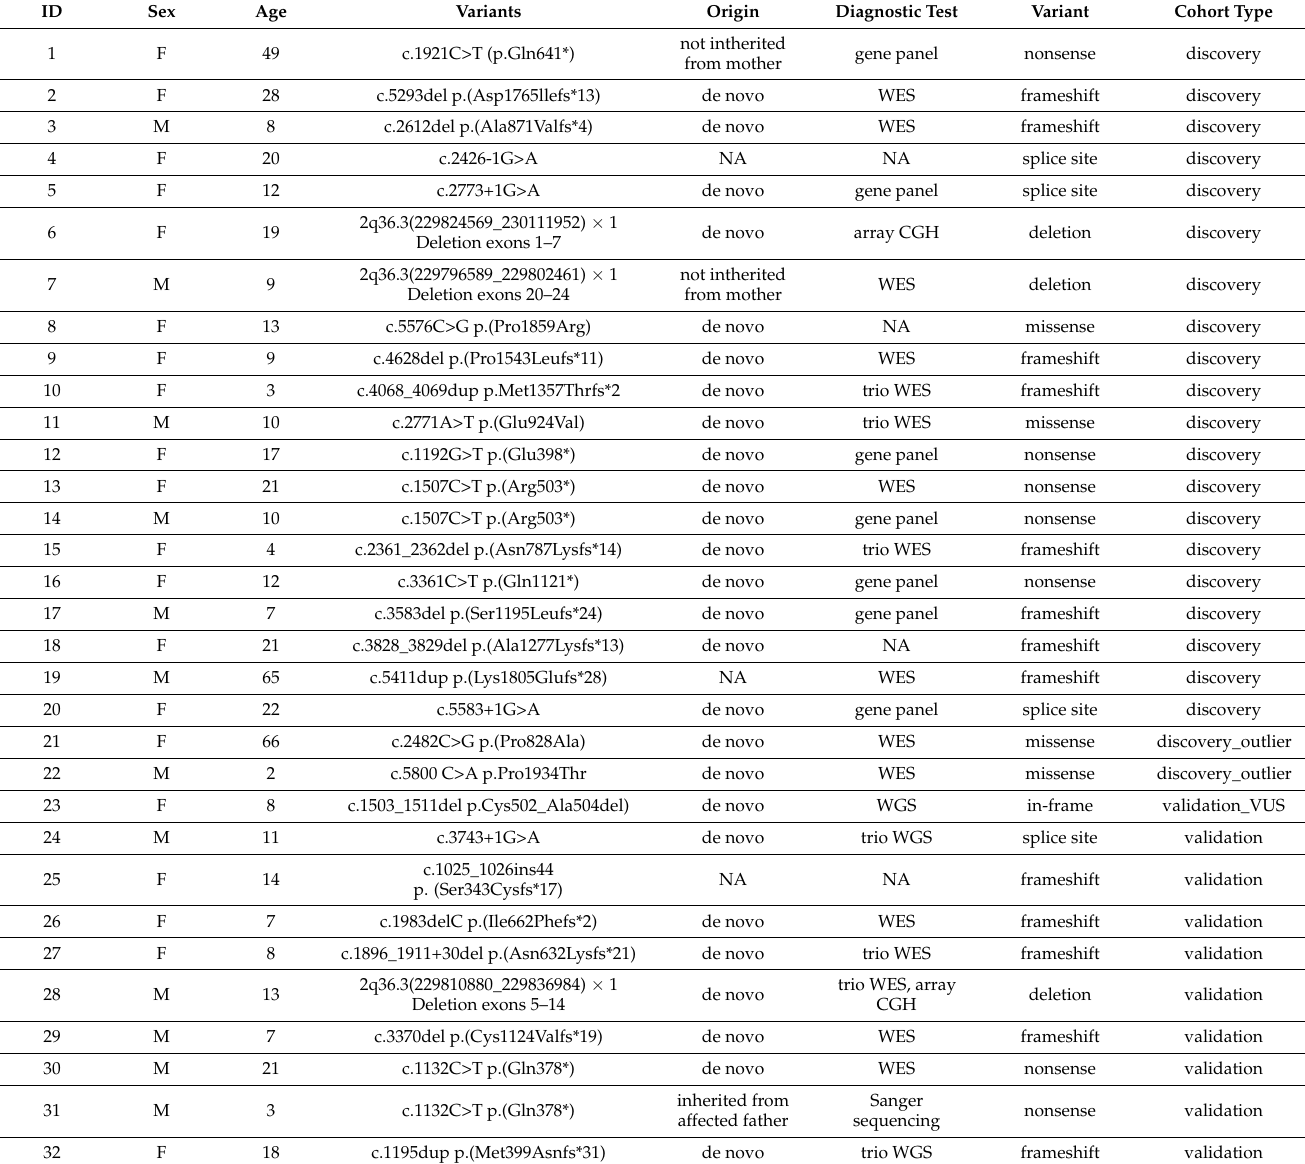
Table 1. Molecular details of the